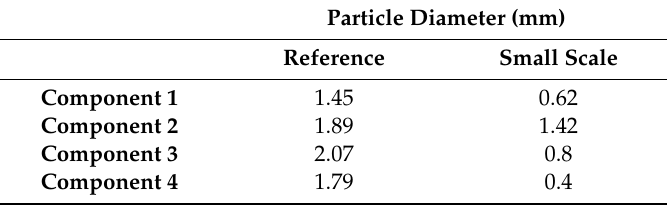
Figure 19. Comparison of the reference process (right) and a small-scale percolation (left) with constant product quality. Table 4. Overview of particle sizes in the reference process and the small-scale continuous extraction.